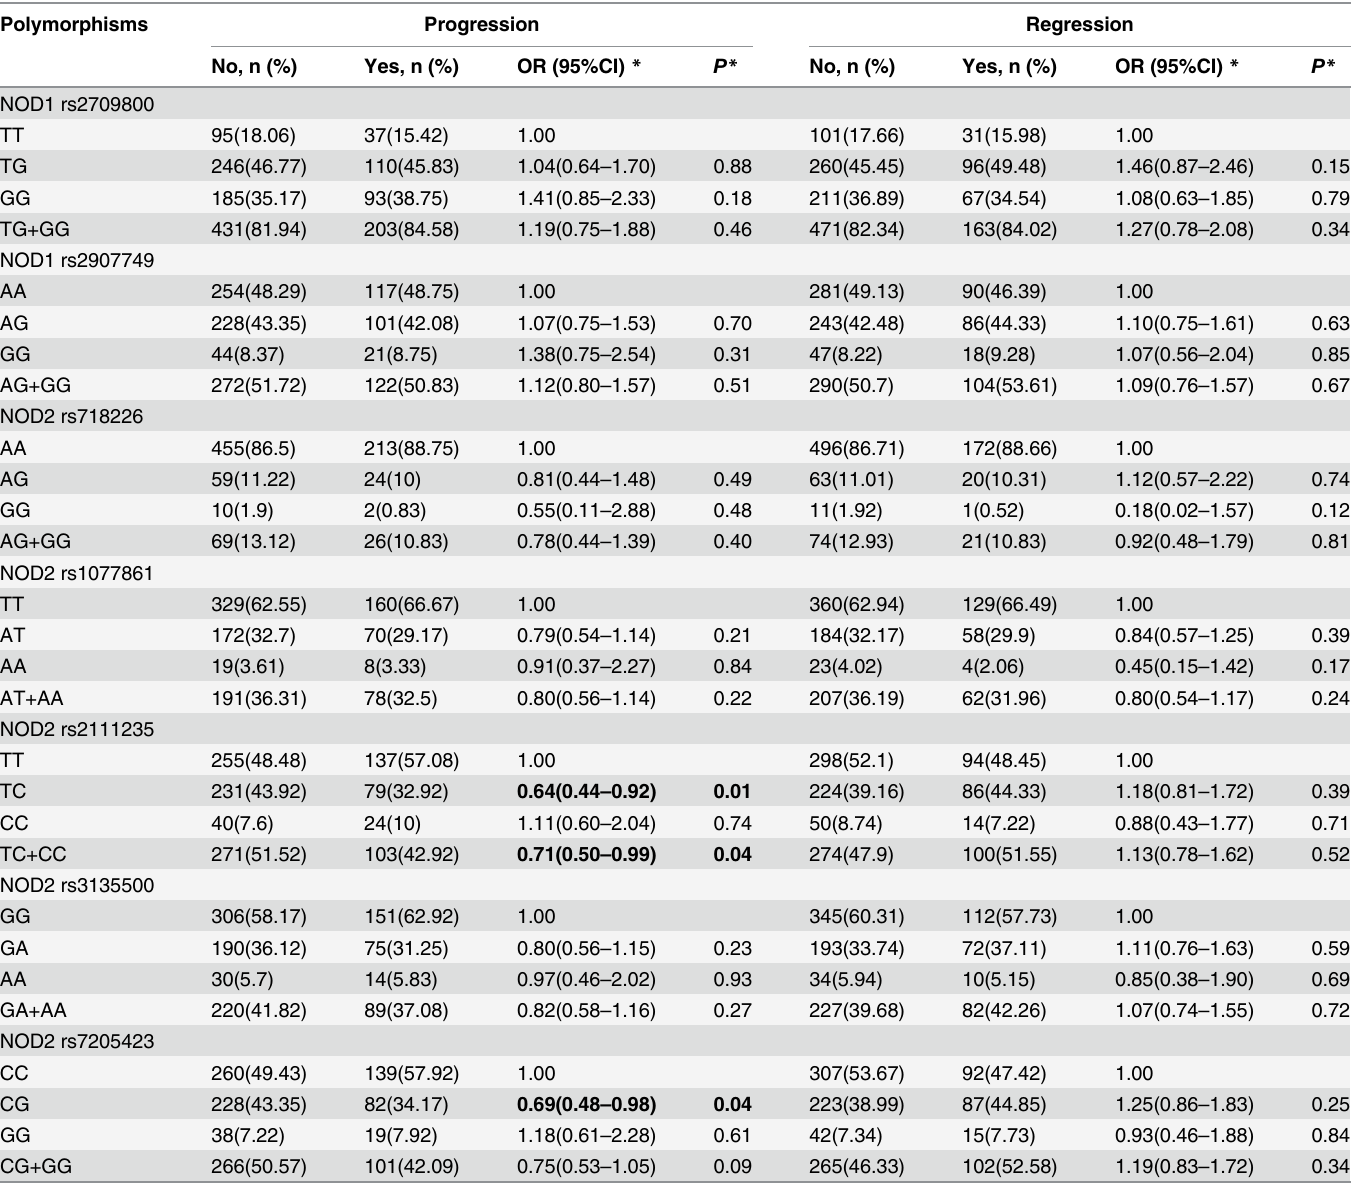
Table 4. Association between polymorphisms and risk of evolution of gastric lesions.